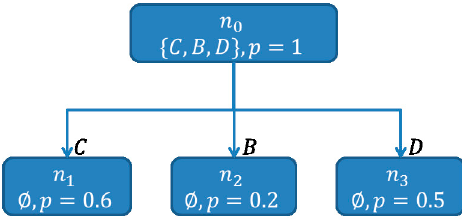
Figure 14. The SHSDAG after the expansion of the root node n 0 . The new child nodes n 1 , n 2 and n 3 have been created and their paths and scores have been updated.